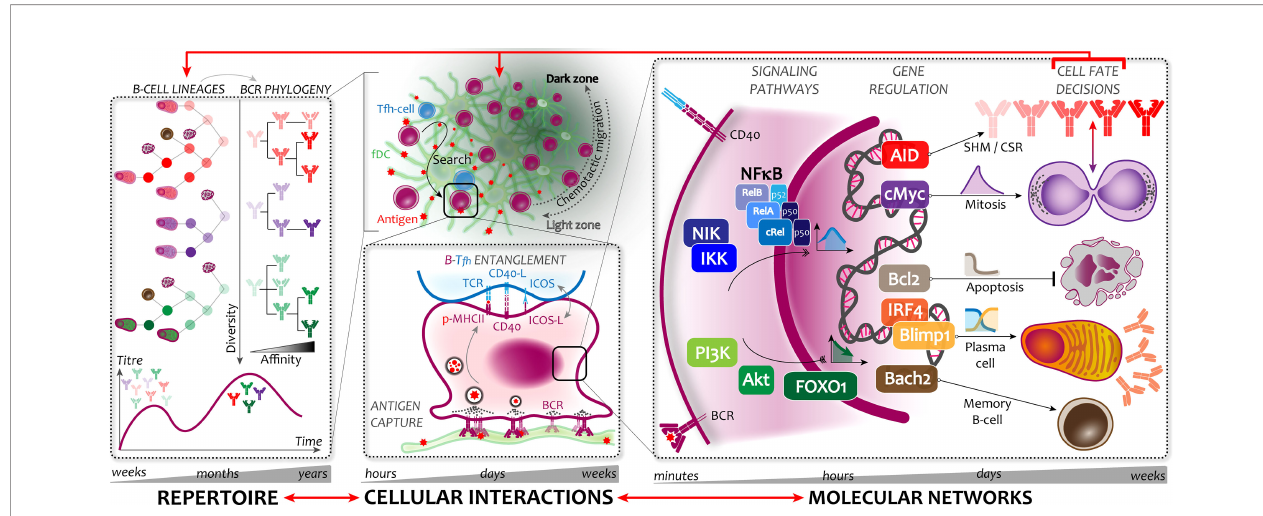
FIGURE 1 | Germinal center dynamics at (Left) repertoire, (Center) cellular interaction, and (Right) molecular network scales. Red arrows indicate connections between scales that remain to be fully explored. (L) Repertoire scale: Af fi nity maturation is shaped by B-cell lineages arising from various founders (shown in different colors) that contribute to clonal diversity of the response, producing plasma and memory cells. Each lineage corresponds to a BCR sequence phylogeny, whose evolution results in increased af fi nity over time (shown in darker shades). The net outcome is the phased production of antibodies over primary and subsequent responses, with lower titers of more diverse but lower af fi nity antibodies at early times, followed by a high-titer, more focused, high-af fi nity repertoire at later stages. (C) Cellular interaction scale: (Top) The germinal center has a spatially segregated structure, with B-cells migrating between zones. (Bottom) The light zone is the site of competitive selection, through af fi nity-based antigen capture and endocytosis, followed by antigen presentation to T-follicular helper cells and B-Tfh entanglement. Recognition of peptide-MHCII complexes by TCRs on Tfh-cells leads to increased contact and attachment, reinforced by ICOS-ICOSL positive feedback, and leading to CD40 signaling in B-cells. B-cells selected via suf fi cient CD40 signaling return to the dark zone to execute various cell fates. (R) Molecular network scale: Signaling in B-cells is mediated by multiple pathways, whose temporal dynamics effect their different cell fate outcomes. Among these, nuclear exit of FOXO1 is implicated in licensing the LZ phenotype, enabling antigen and Tfh encounters. Nuclear translocation of NF k B induces transcription factors that regulate B-cell survival, division, and differentiation. B-cell division is accompanied by hypermutation of BCR sequences, which in fl uence future antigen and Tfh encounters, hence the subsequent B-cell fates that shape their lineages, thus ultimately driving the antibody and memory repertoire